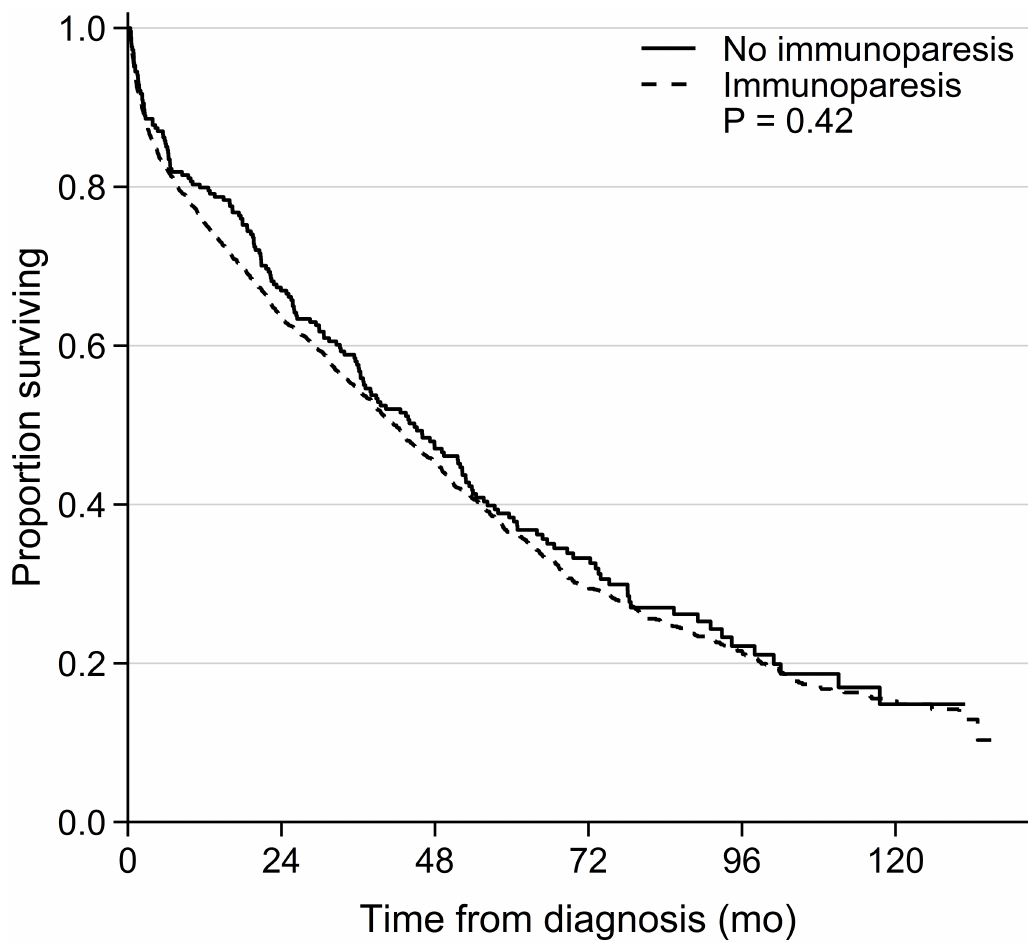
Fig 1. OS for patients with and without qualitative